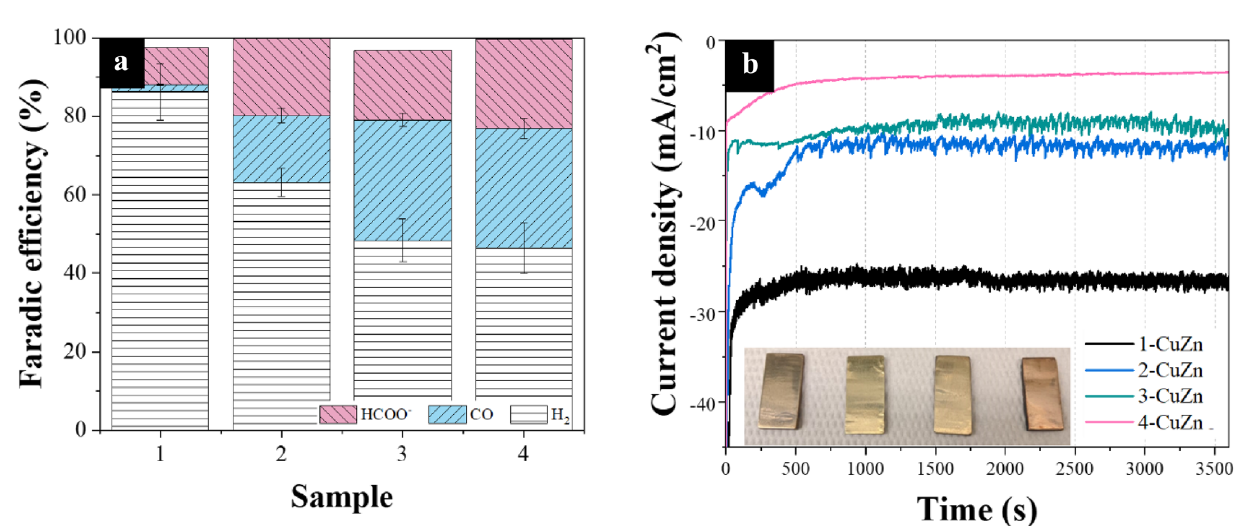
Figure 3. The electrocatalytic performance of the samples at a potential of − 0.91 V vs. RHE. ( a ) The measured Faradic efficiencies and ( b ) the chronoamperometry profiles with an inset of a photograph of the 4 polished brass